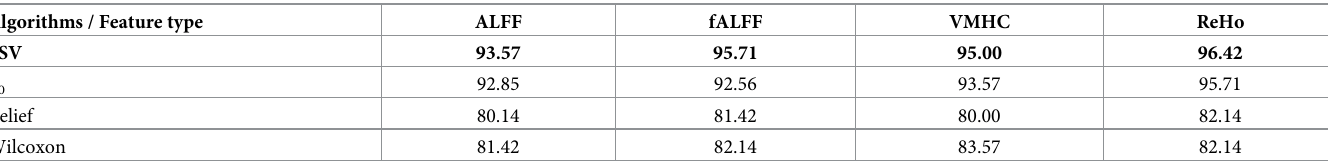
Table 2. Classification accuracy (%) with feature selection algorithms and feature types.